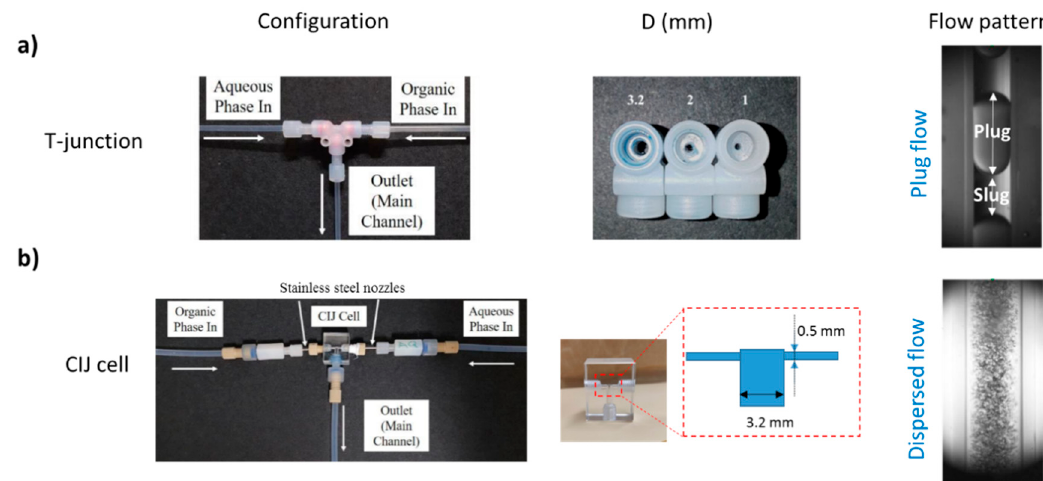
Figure 2. Images of the small-scale inlets used and indicative photos of flow patterns obtained in ( a ) T-junction (plug flow) and ( b ) Confined impinging-jets (CIJ) cell (dispersed flow).